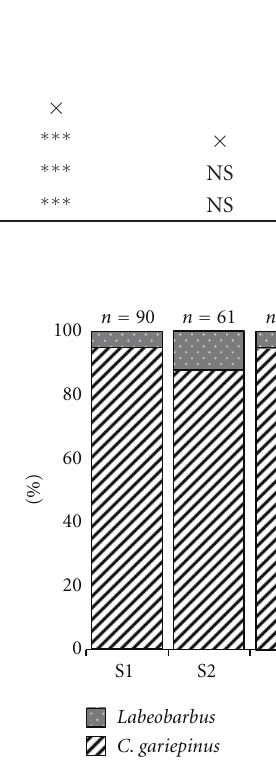
Figure 4: Percentage contribution of Labeobarbus spp. and C. gariepinus collected from the six di ff erent sampling sites of Shesher and Welala wetlands. Pooled data collected from July to October. “S” and “W” stand for Shesher and Welala, respectively. “ n ”, number of